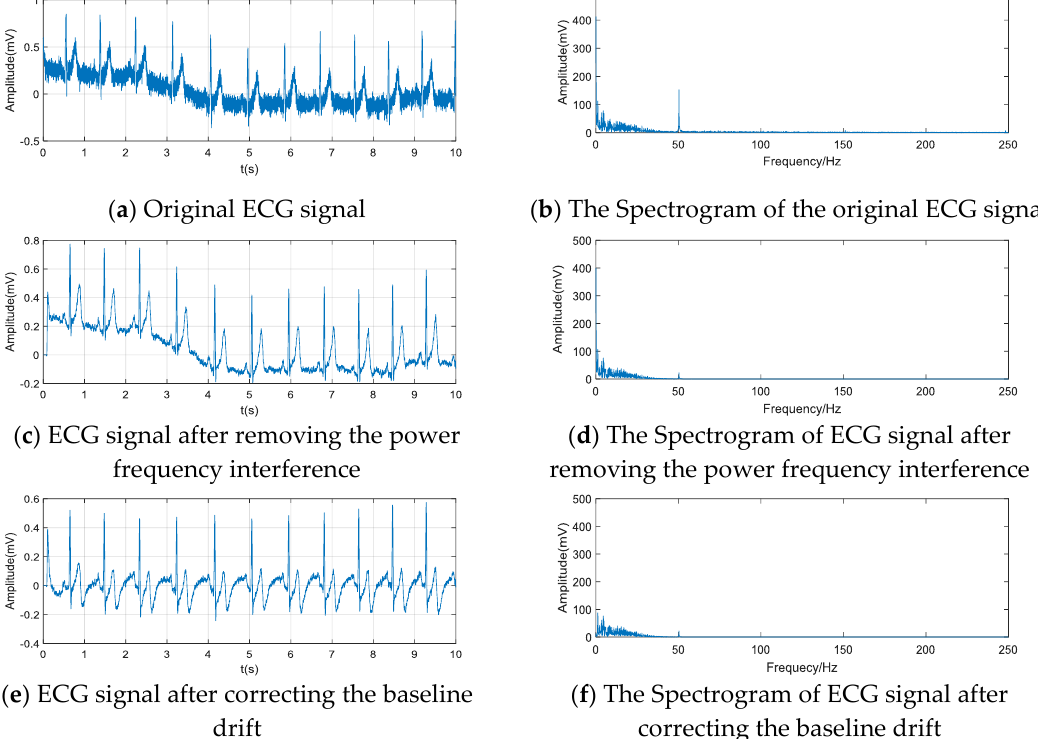
Figure 3. ECG signals before and after filtering and their spectrograms.